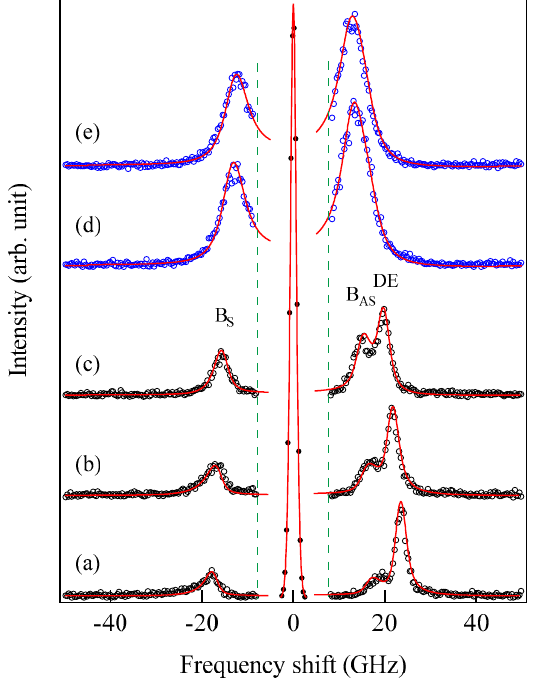
Figure 32. BLS spectrum from the SPM and FM Co‑Al‑O films at room temperature under an external magnetic field of 2.0 kOe. Here, ( a ) x (Co) = 72.4, ( b ) x (Co) = 67.5, ( c ) x (Co) = 63.1, ( d ) x (Co) = 50.3, and ( e ) x (Co) = 49.9, respectively. The baseline for each spectrum was properly shifted for clarity’s sake. The solid lines give the numerical fits by the CM theory. The vertical broken lines indicate the frequency area in which the AOMs were activated to protect the PMT. An intensity‑attenuated elastic Rayleigh peak around zero frequency is also displayed. This peak gives the instrumental function [101].